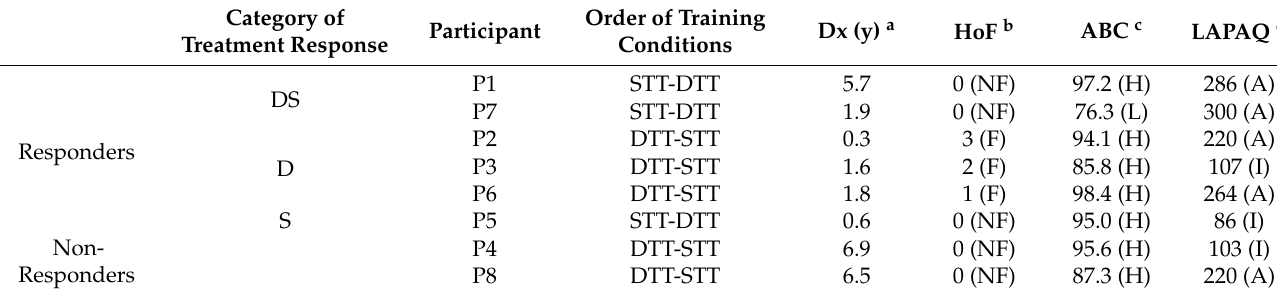
Table A4. Categorization of treatment responses (i.e, DS, D, and S), and common demographic and clinical characteristics of treatment responders within each